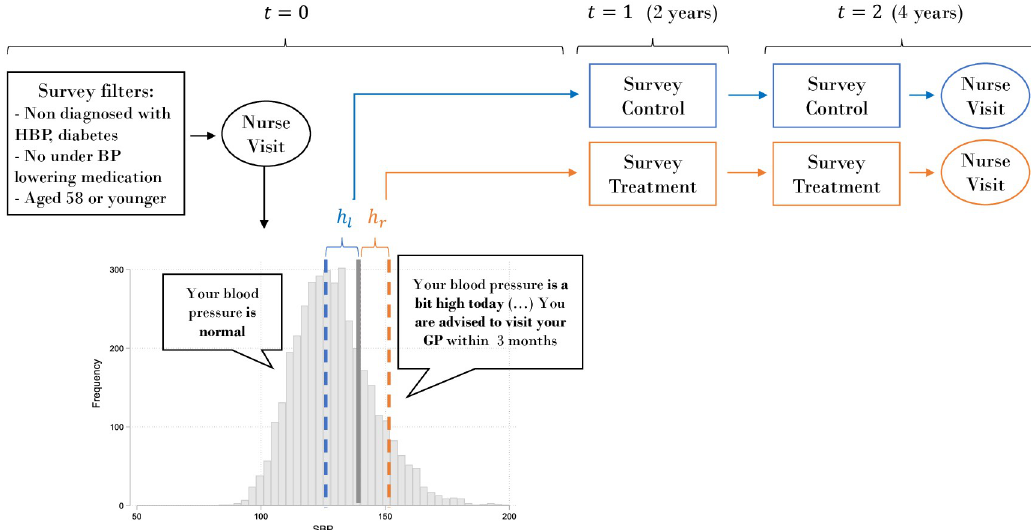
Fig 1. Systolic blood pressure distribution and nurses’